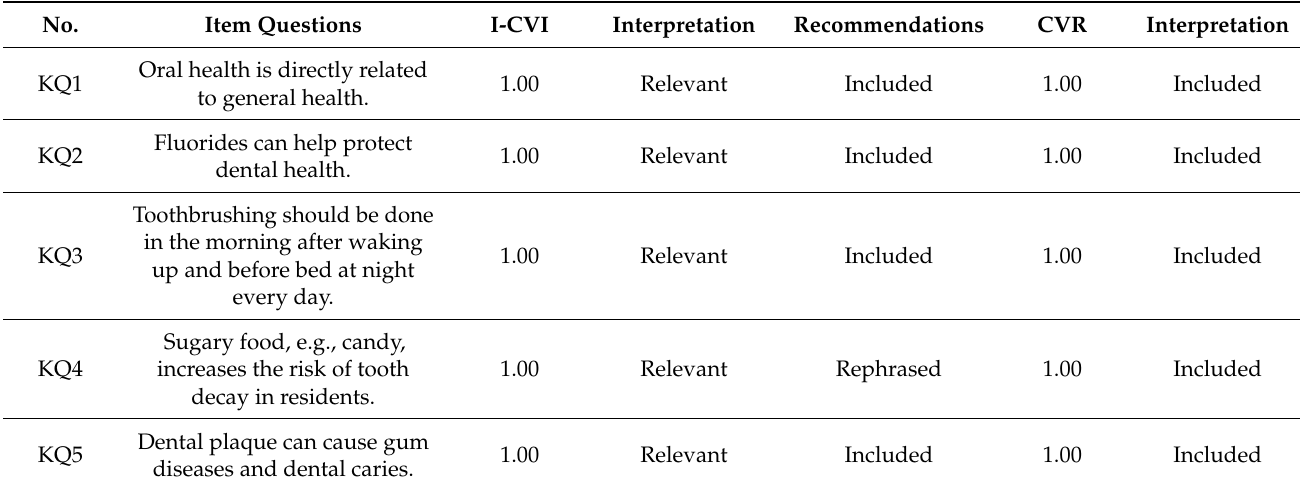
Table 2. Calculation of the I-CVI and CVR for each